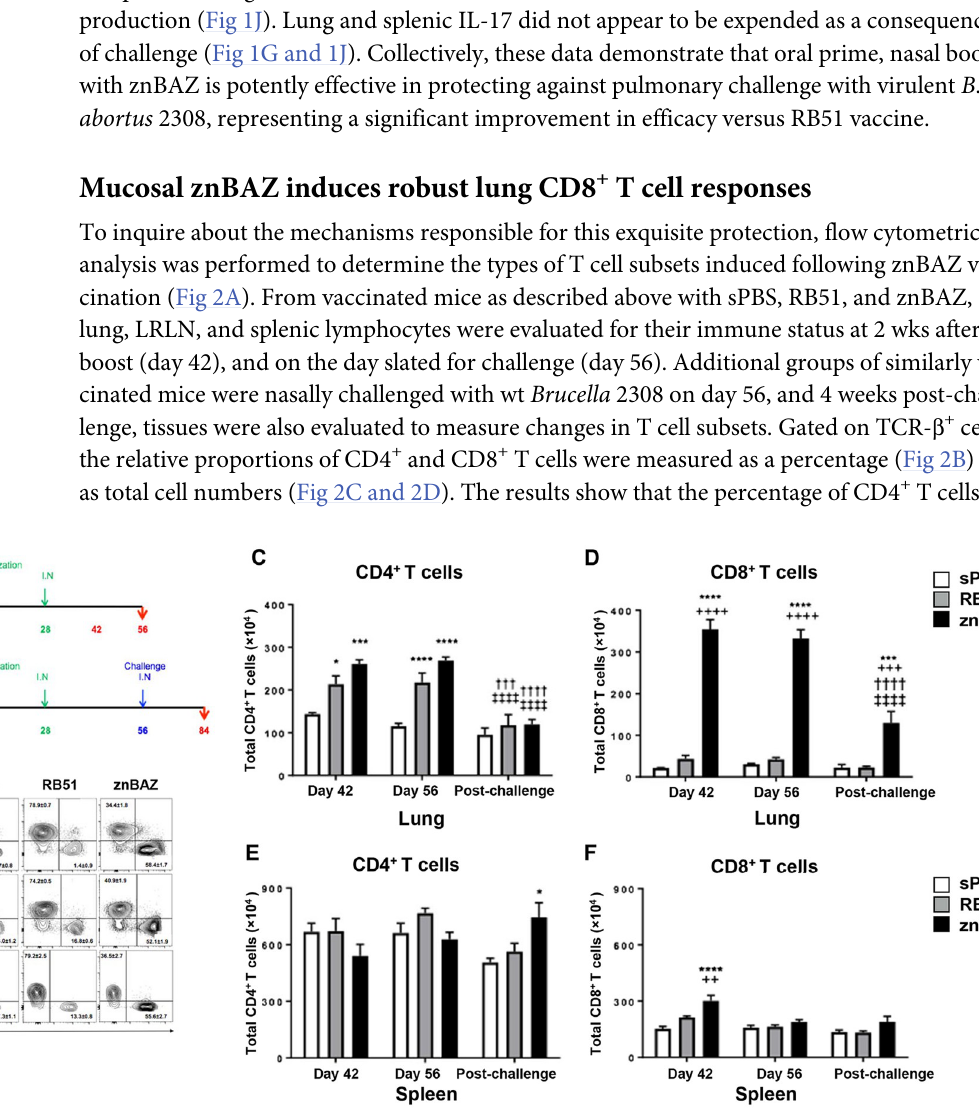
Fig 2. Mucosal znBAZ enhances the recruitment of Brucella -specific CD8 + T cells into the lungs. (A) BALB/c mice were orally primed and nasally boosted as described. On days 42 and 56, lymphoid tissues were isolated to evaluate their T cell content by FACS analysis. Additional groups of mice, subjected to the same immunization regimen, were challenged with wt B . abortus 2308 (5 × 10 4 CFUs) on day 56. Four weeks post-challenge, lymphoid tissues were isolated to evaluate the T cell infiltration. (B) Flow cytometry of CD4 + and CD8 + expression from gated TCR- β + cells in the lungs at 42, 56, and 84 days after oral prime. Total numbers of (C, E) CD4 + and (D, F) CD8 + T cells in the (C, D) lungs and in the (E, F) spleen at various time points. The data depict n = 12 mice per group from two independent experiments. The differences were determined when compared to sPBS-dosed mice ( ���� P < 0.0001, ��� P < 0.001, �� P < 0.01, � P < 0.05), or compared to RB51-vaccinated mice ( ++++ P < 0.0001, +++ P < 0.001, ++ P < 0.01, + P < 0.05). The difference among the time points were determined when compared to day 42 ( †††† P < 0.0001, ††† P < 0.001, †† P < 0.01, † P < 0.05), or compared to day